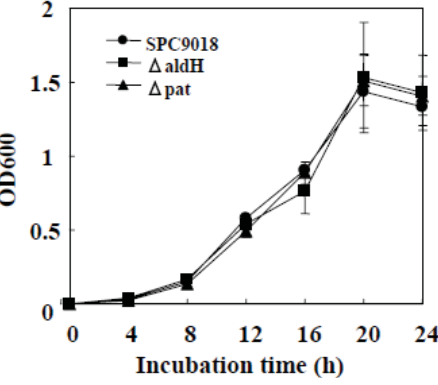
Figure 1. Growth of P. cichorii strains incubated in